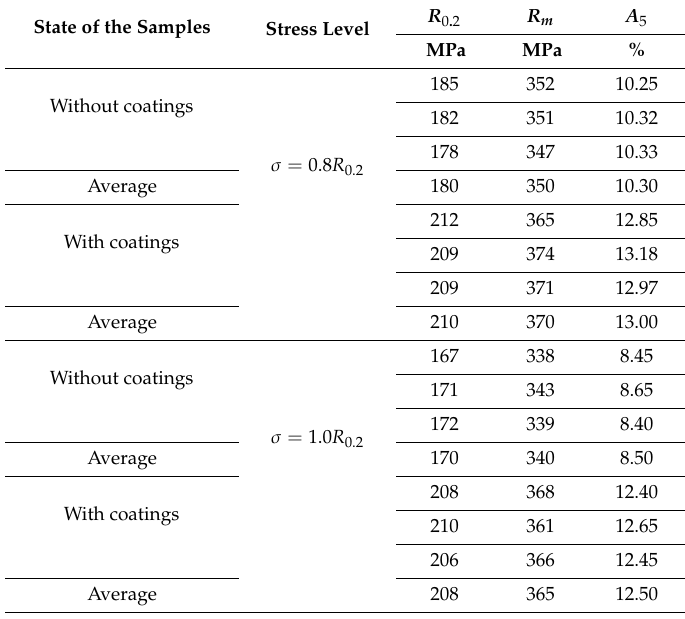
Table 3. Mechanical properties of samples with and without coatings of AlMg6 alloy after exposure to stress corrosion at time t = 480